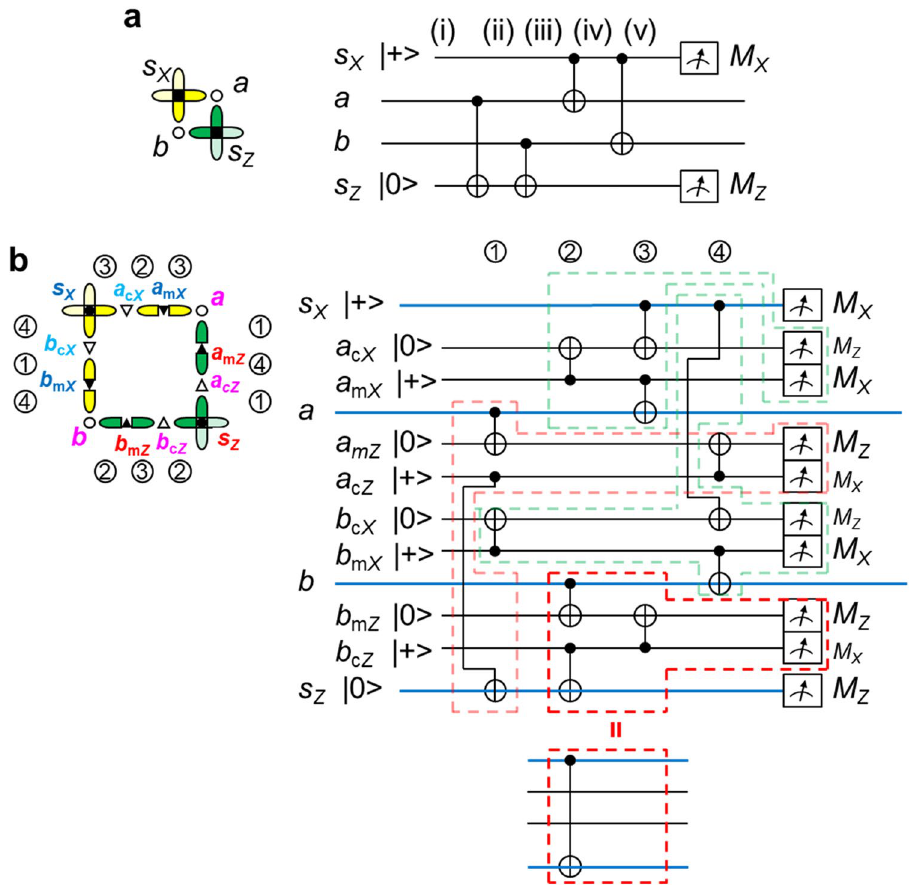
Figure 3. Part of a stabilizer measurement. Data qubits a and b are common between the X - and Z -stabilizers. Syndrome qubits s X and s Z are measured in the X - and Z -bases, respectively. ( a ) Ordinary surface code case. ( b ) Low-density qubit array case. a m Z , a m X , b m Z and b m X are mediator qubits; a c Z , a c X , b c Z and b c X are copy qubits. The circuit in ( b ) is equivalent to that in ( a ) if feedforward is done in accordance with the measurement results of mediator and copy qubits; the operation principle is based on that in Fig. 2d–g. Each area surrounded by dashed lines is equivalent to a CNOT in this sense.